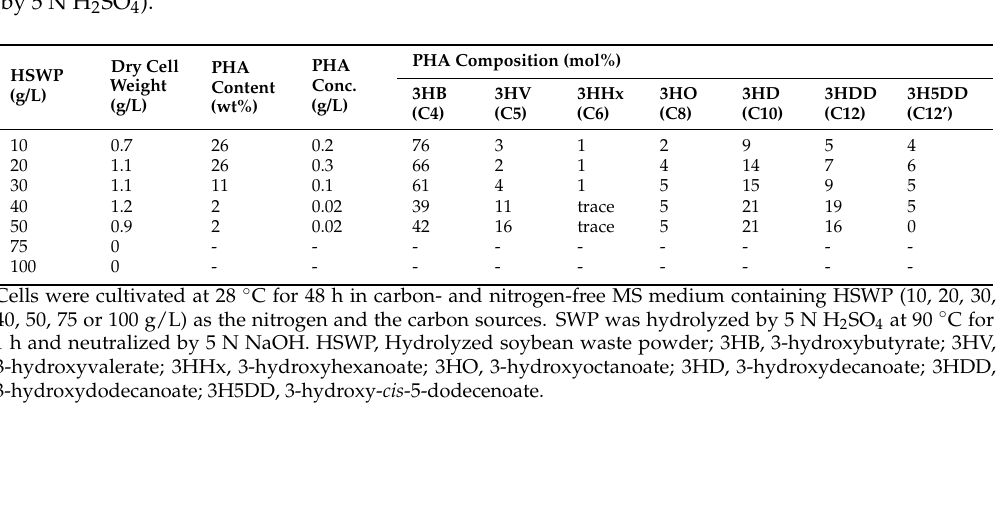
Table 4. Biosynthesis of PHA in Pseudomonas sp. 61-3 ( phbC :: tet ) harboring pJKSc54- phab from HSWP (by 5 N H 2 SO 4